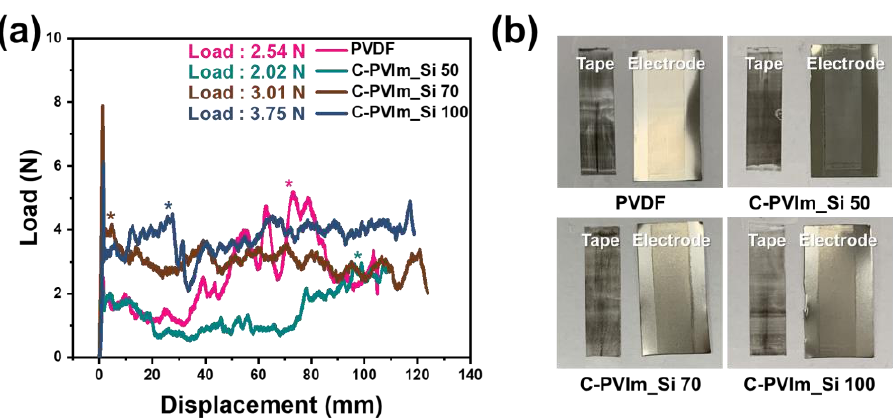
Figure 5. ( a ) The 180° peel tests for the Ni electrode with different binders; ( b ) optical images of the tape and electrode surface after the peel test.